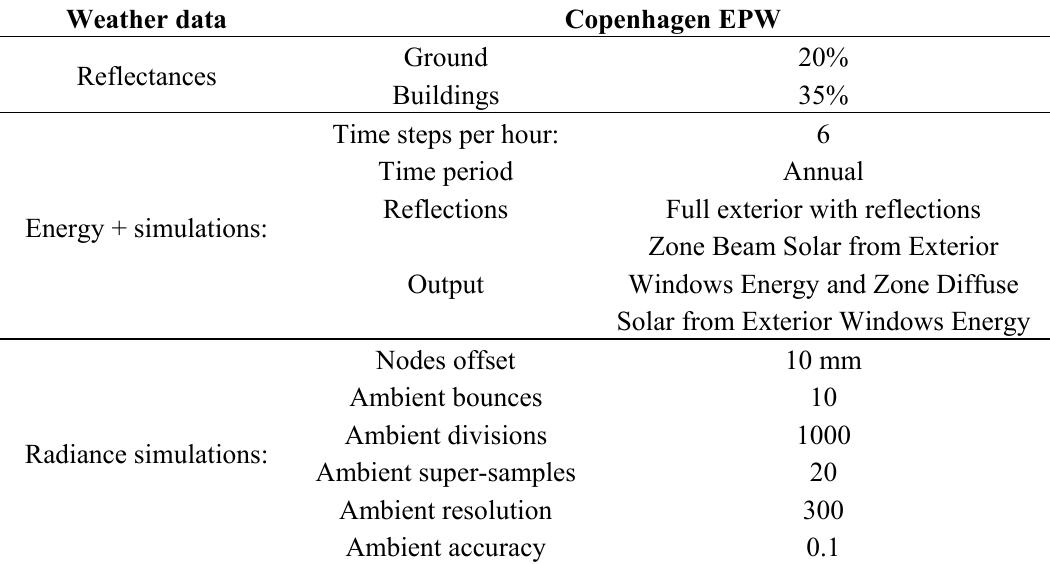
Table 1. DIVA4Rhino settings for Radiance/Daysim and EnergyPlus